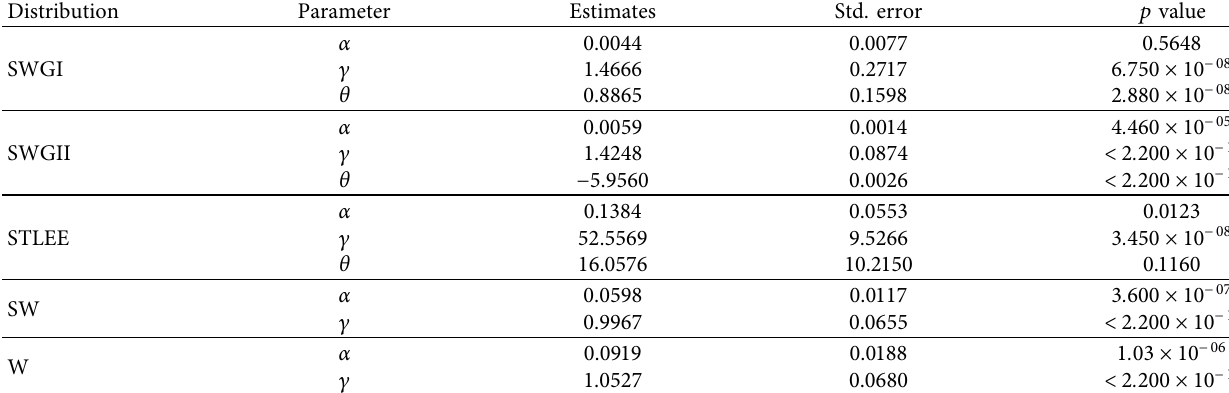
Table 5: Parameter estimates of bladder cancer remission